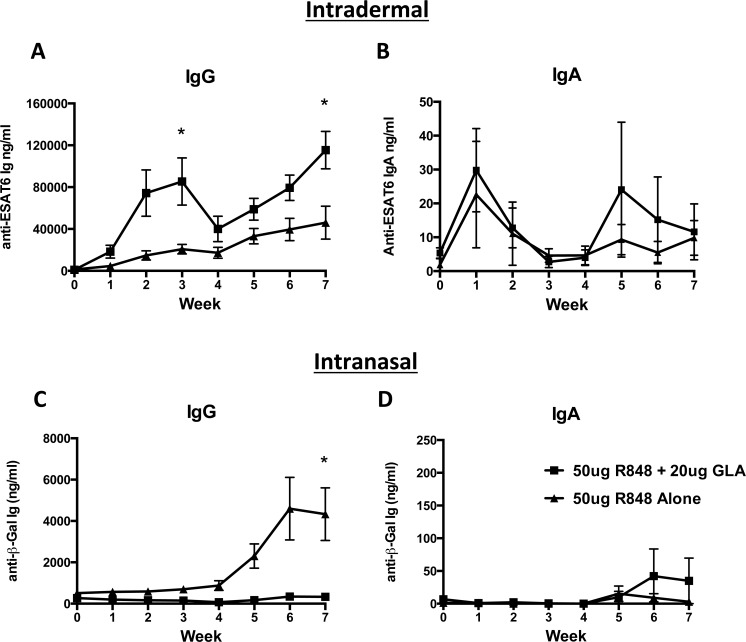
GLA-AF enhances R848 induced humoral responses after ID injection.A) The TLR4 agonist GLA-AF (20 μg) increased the TLR7 (R848–50 μg) adjuvanted ESAT-6 (recombinant M. tuberculosis early secreted antigenic target-6 kDa) antigen-specific IgG responses four-fold after a single prime and one boost ID vaccination (* p = 0.0335; Week 3 and p = 0.0338; Week 7). B) The combination of GLA-AF and R848 had no effect on serum IgA responses over R848 alone. C) The TLR4 agonist GLA-AF significantly ablated the R848 induced β-Gal (Beta galactosidase) antigen-specific IgG responses after IN injection (* p = 0.0261; Week 7). D) The combination of GLA-AF and R848 as well as R848 alone poorly augmented antigen-specific β-Gal serum IgA responses.